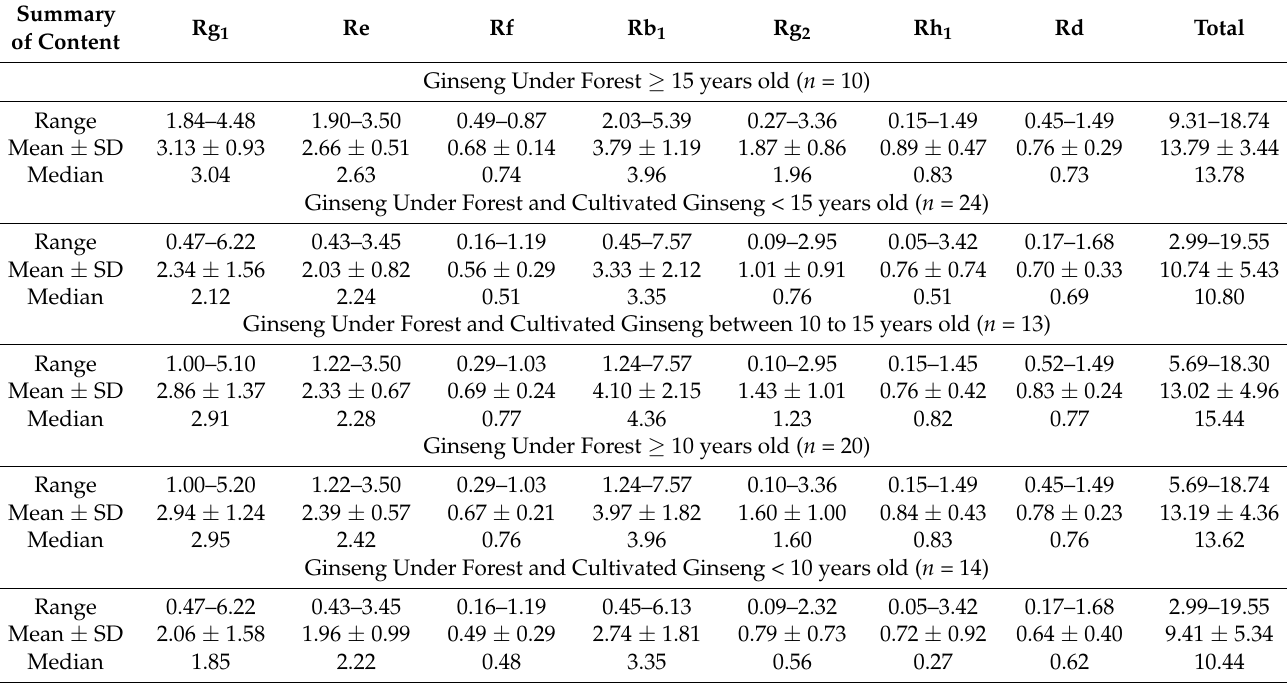
Table 5. Mean, median and range of seven ginsenosides’ contents (mg/g) in ginseng (including ginseng under forest and cultivated ginseng) with different growing ages.